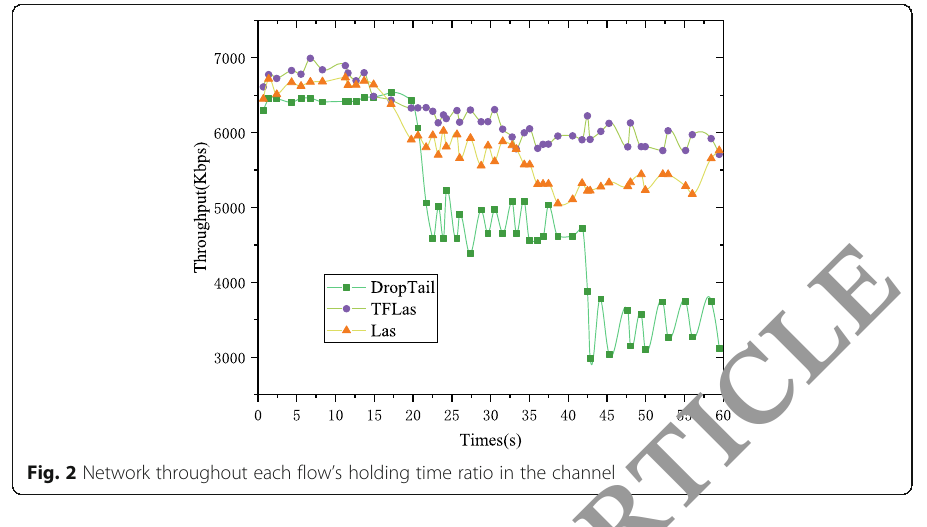
Fig. 2 Network throughout each flow ’ s holding time ratio in the channel